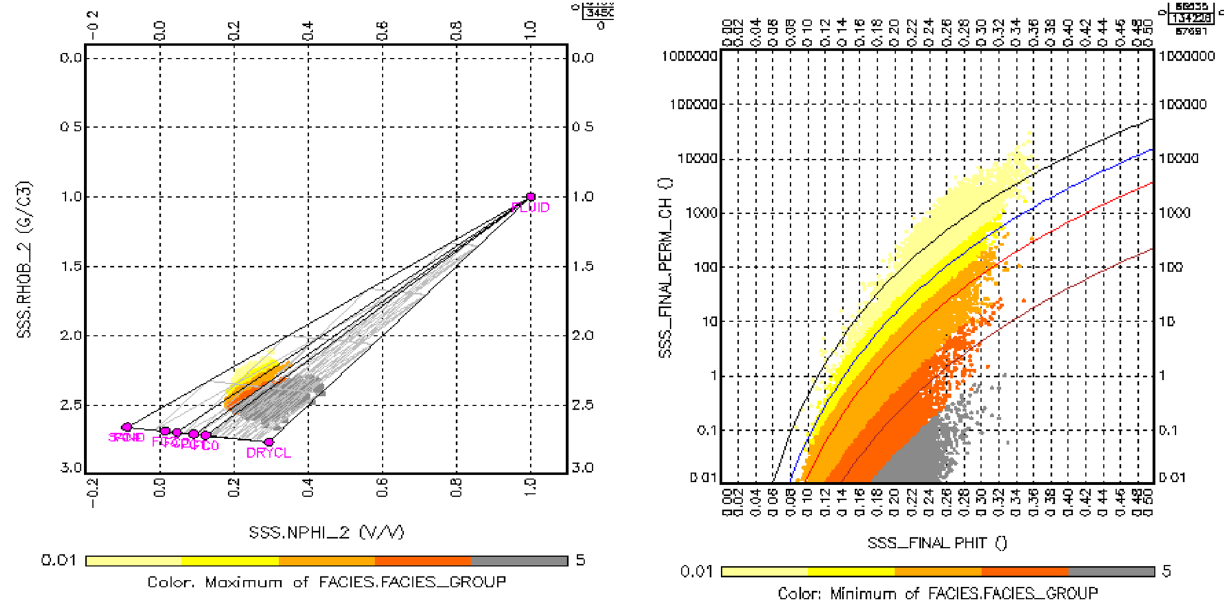
Fig. 4 Determination of electro-facies based on neutron-density cross